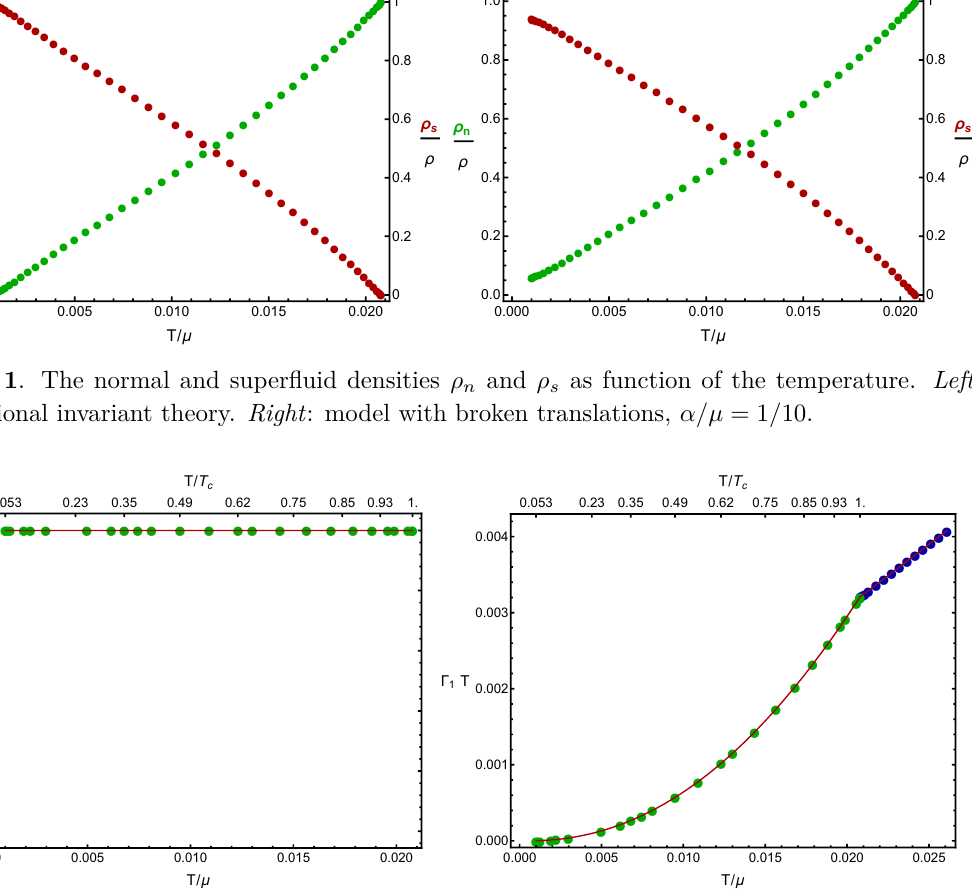
Figure 2 . The propagation speed and the attenuation constant of first sound as function of T/T c above and below the critical point. The red lines are the hydrodynamic formulas (2.1), (2.2) and the colored circles the numerical data extracted from the QNMs. Blue color indicates the normal phase. The plot for the speed is not extended into the normal phase since the speed is trivially constant in the full range of T due to the conformal